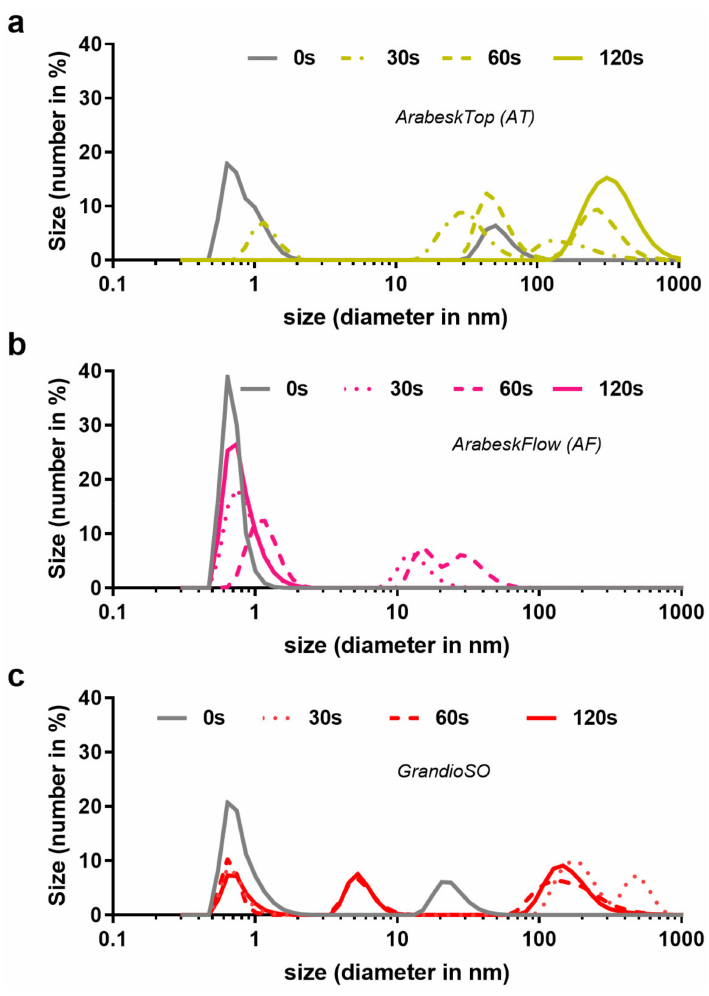
Figure 6. Resin particle release into buffered solution. ( a – c ) particle size estimations using dynamic light scattering (DLS) of untreated and gas plasma-treated (30 s, 60 s, and 120 s) AT ( a ), AF ( b ), and GSO in phosphate-buffered saline, in which the materials were incubated for 24 h prior to